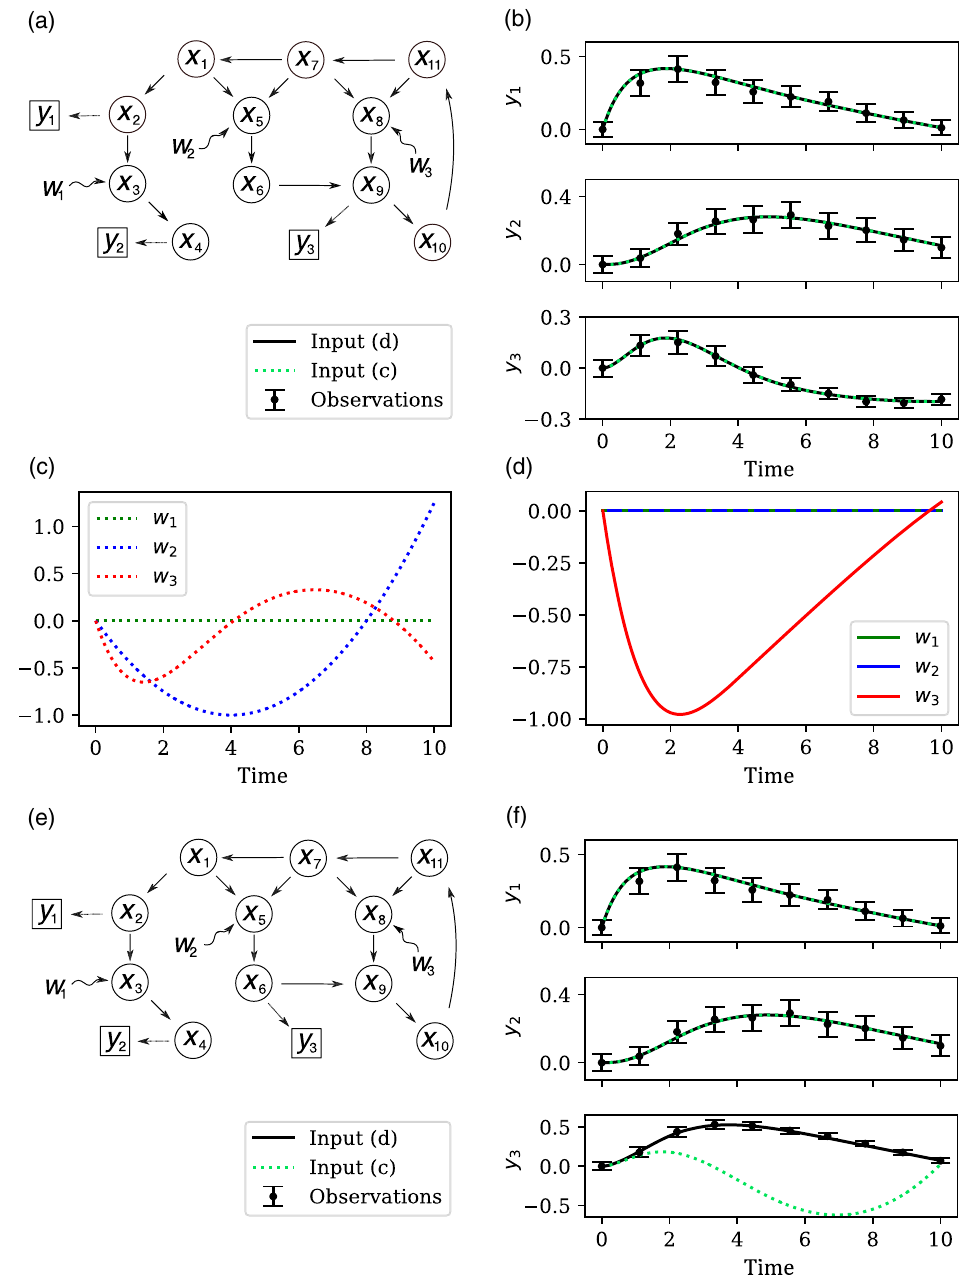
FIG. 2. Invertibility of a dynamic system. (a) The influence graph represents the states x ¼ ð x 1 ; … ; x 9 Þ of a system as nodes (circles). Endogenous interactions are indicated by arrows between the states. This system receives three input signals w ð t Þ ¼ ½ w 1 ð t Þ ; w 2 ð t Þ ; w 3 ð t Þ(cid:2) (wiggly arrows) targeting the input nodes S ¼ f x 3 ; x 5 ; x 8 g . The output y ð t Þ ¼ ½ y 1 ð t Þ ; y 2 ð t Þ ; y 3 ð t Þ(cid:2) (squares) is given by measurements of the state variables in the sensor node set Z ¼ f x 2 ; x 4 ; x 9 g . (b) The measured output data (dots) of the open system can be explained by different input signals (c),(d) causing identical outputs, as indicated by the dotted line for input (c) and by the solid line for input (d). Thus, the system is not invertible. (e) For Z ¼ f x 2 ; x 4 ; x 6 g , i.e., if the sensor for the output y 3 is moved to state x 6 instead of x 9 [compare (a)], we obtain an invertible system, and the input signal in (d) is unique for the observed output in